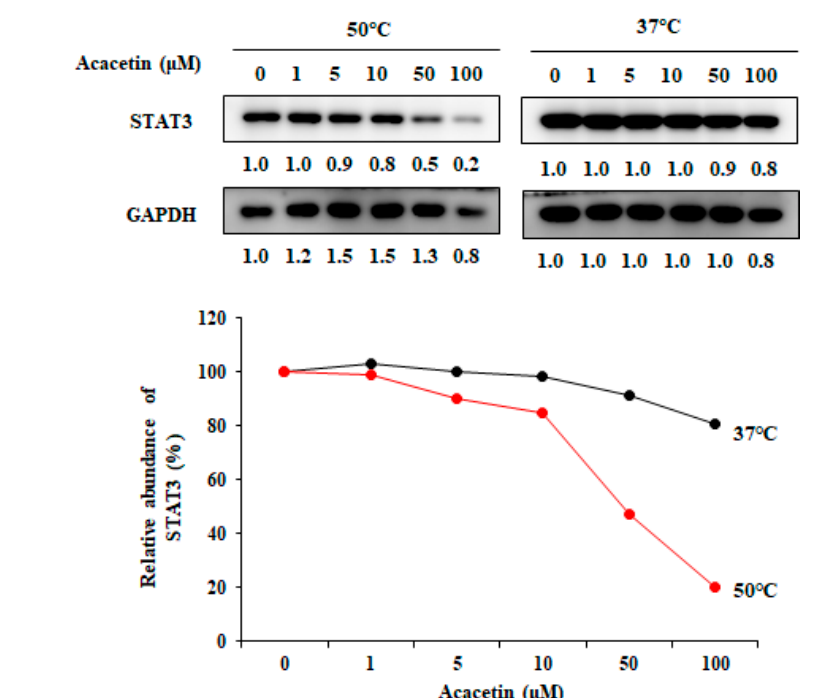
Figure 6. Acacetin directly binds to STAT3 in DU145 cells. ( A ) DU145 cell lysates were incubated with acacetin (500 µ M) for 1 h at room temperature and then proteolyzed with increasing concentrations of pronase for 10 min ( n = 2). ( B ) DU145 cell lysates were incubated with increasing concentrations of acacetin for 1 h at room temperature and then were proteolyzed with pronase for 10 min ( n = 2). The pronase-resistant proteins in the presence or absence of acacetin were analyzed by Western blotting. ( C , D ) CETSA was performed with cell lysates of DU145 cells that were treated with DMSO or acacetin (500 µ M) for 1 h with an increasing melting temperature (42–64 ◦ C, interval temperature: 2 ◦ C) ( C ) or drug concentration ( D ) ( n = 2). The band intensity of each protein was quantified using the MultiGauge program. The data represent the means ± s.d.; comparisons were performed with t -tests; * p < 0.05, ** p < 0.01.